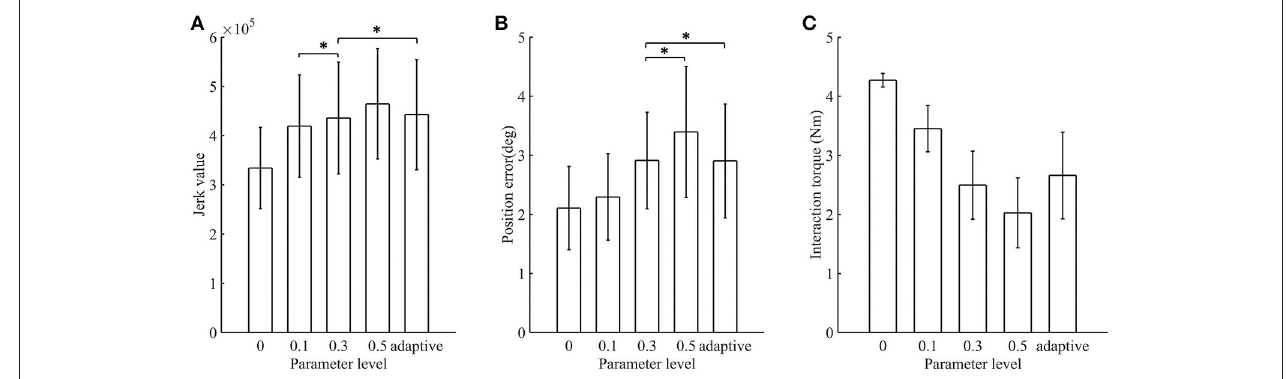
FIGURE 7 | The mean value and standard deviation of indicators at different control schemes: (A) Jerk value; (B) Position error; (C) Interaction torque. Adaptive, AACS. *indicates that there was no significant difference between the groups ( p > 0.05 and n